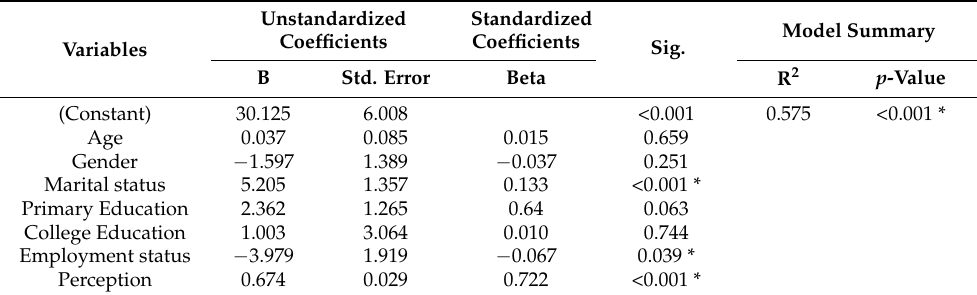
Table 4. Multiple regression analysis for variables associated with